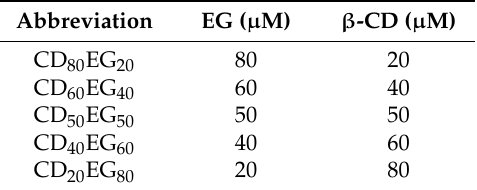
Table 1. Epigallocatechin-3-gallate reacts with β -cyclodextrin at various ratios to form CD-EG complexes.